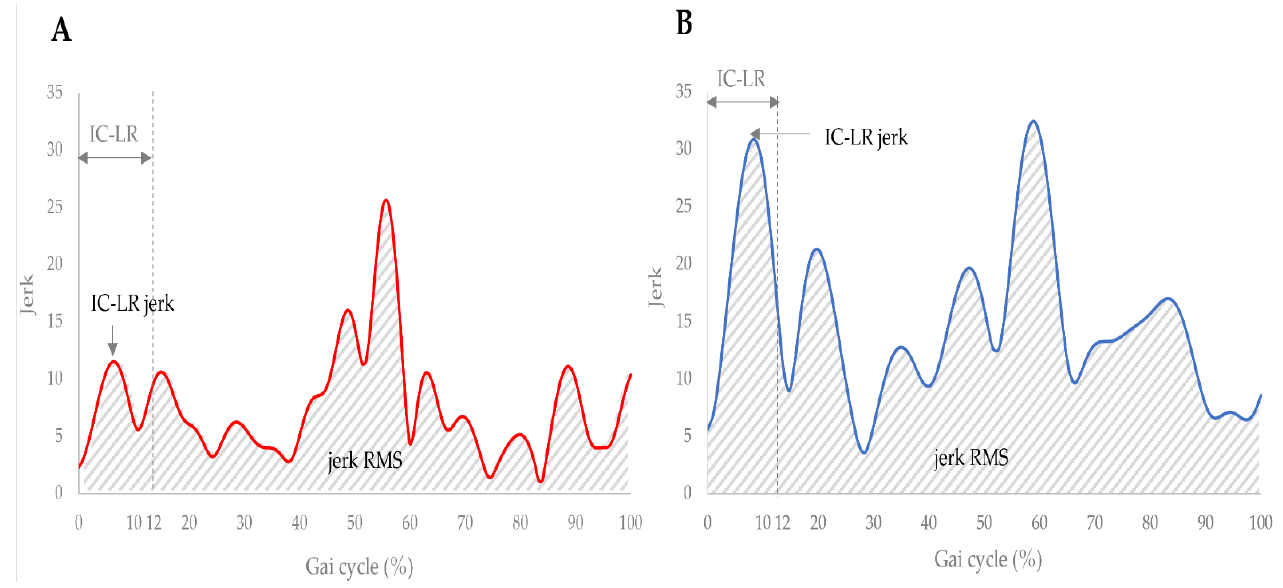
Figure 3. Jerk of excellent and poor cases of gliding between tissues. ( A ) Excellent case, ( B ) Poor